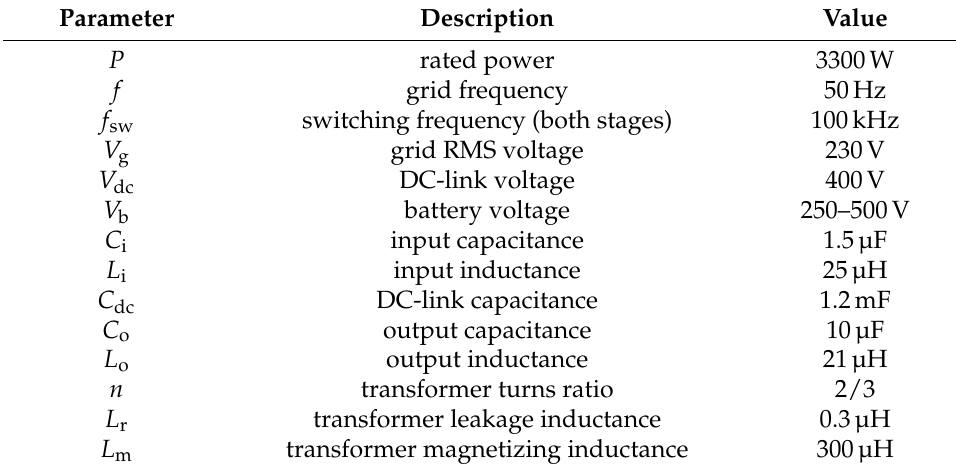
Table 1. Main parameters and specifications of the considered